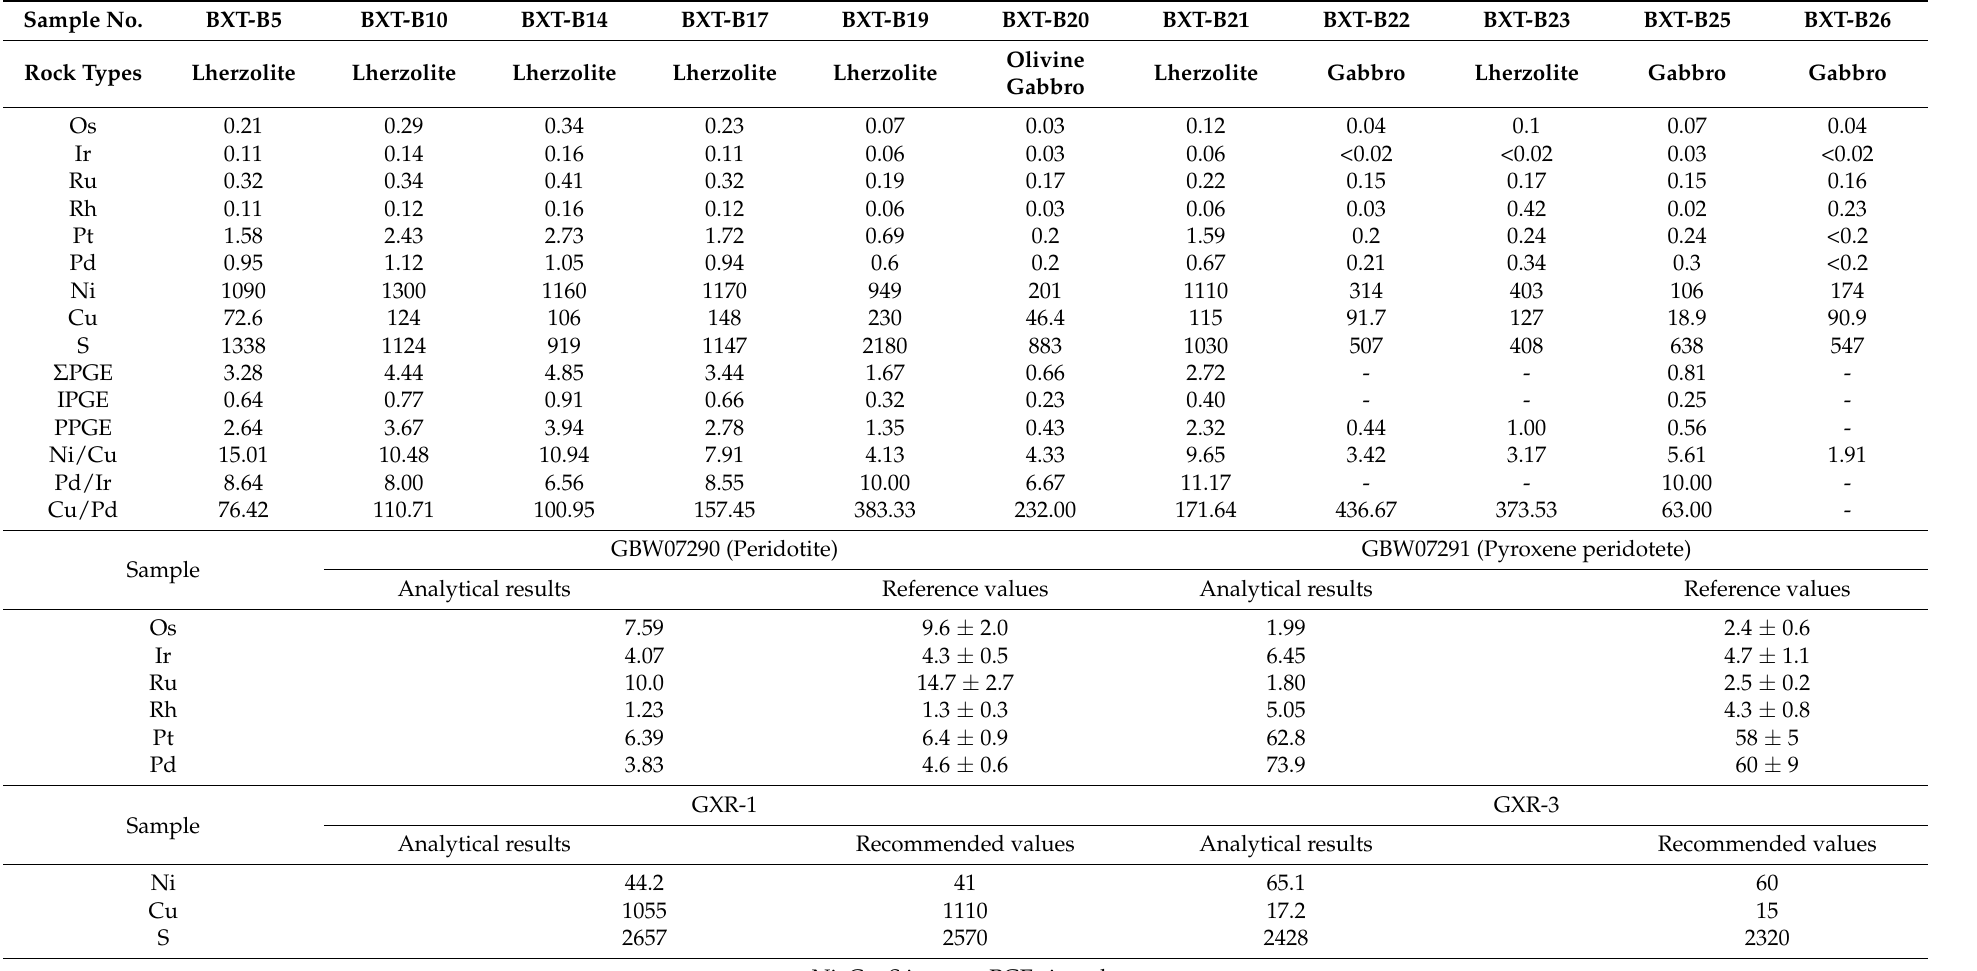
Table A5. Concentrations of chalcophile elements in the Baixintan